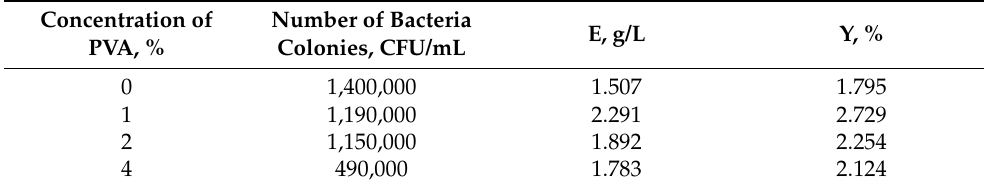
Table 1. A number of bacteria colonies (CFU/mL) in SH culture media (with and without the addition of 1, 2, and 4% of PVA), efficiency (E, g/L), and yield (Y, %) of biosynthesis. Concentration of Number of Bacteria PVA, % Colonies, CFU/mL